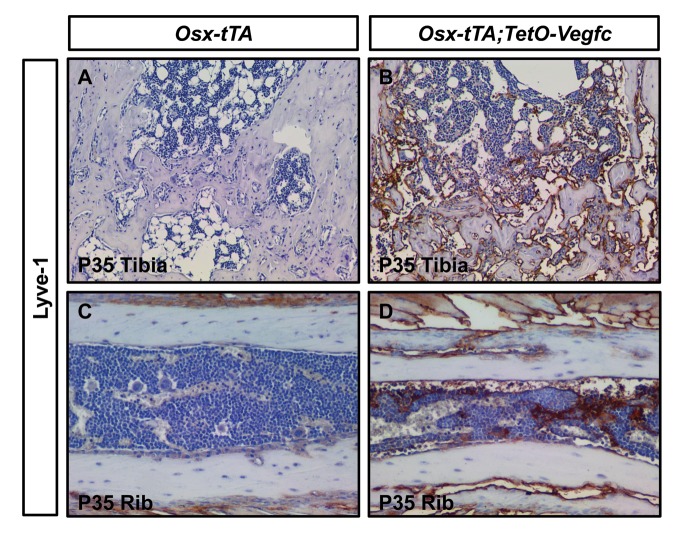
Bone lymphatics express Lyve-1.(A) No Lyve-1-positive cells are in tibias from P35 Osx-tTA mice. (B) Numerous Lyve-1-positive lymphatics are in tibias from P35 Osx-tTA;TetO-Vegfc mice. (C) No Lyve-1-positive cells are in ribs from P35 Osx-tTA mice. (D) Numerous Lyve-1-positive lymphatics are in ribs from P35 Osx-tTA;TetO-Vegfc mice.